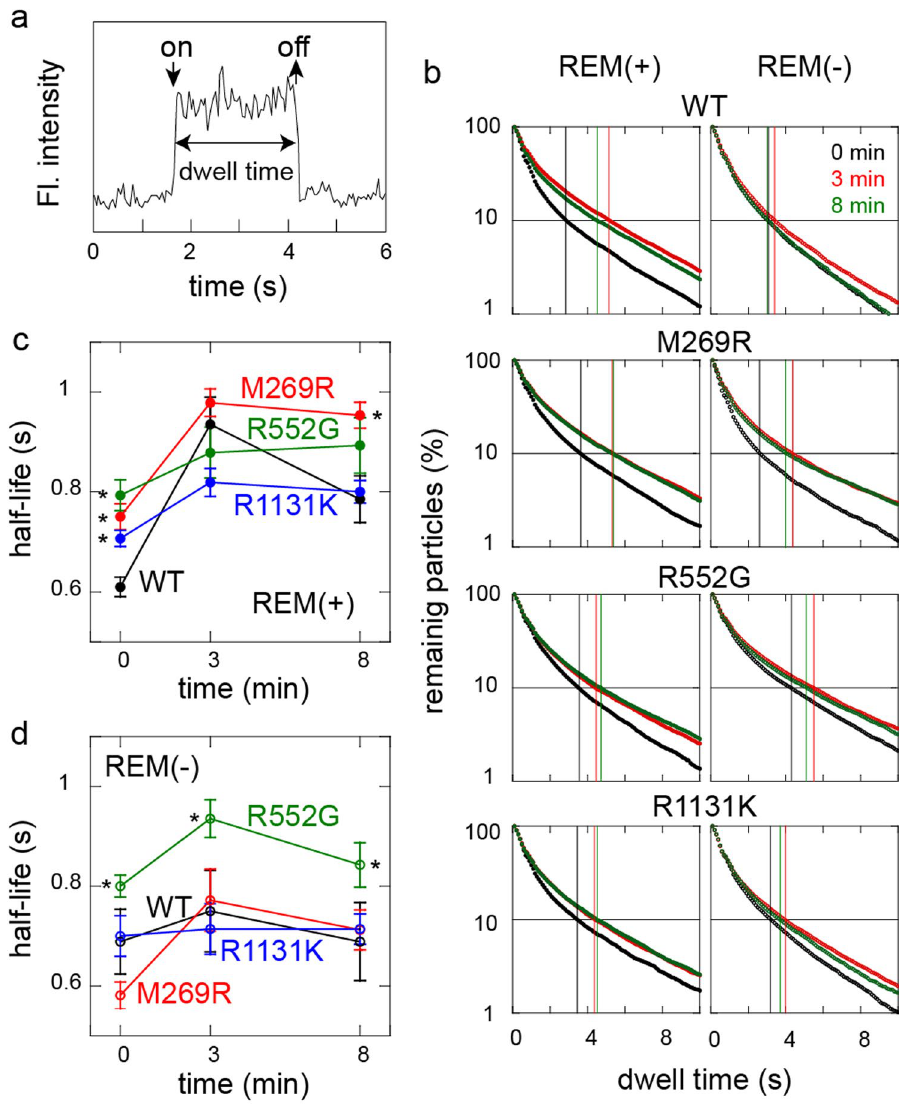
Figure 3. Dwell time distributions of NS SOS mutants on the cell surface. ( a ) Example of the change in fluorescence intensity on the cell surface, showing the association (on) and dissociation (off) of a single SOS molecule. ( b ) Release curves of SOS molecules from the cell surface. Molecules contained the REM( − ) mutation (left) or did not (right). A total of 624–7222 molecules were observed under each condition. Black, red, and green plots show the curves obtained after stimulation with EGF for 0, 3, and 8 min, respectively. The vertical lines show the dwell times at the 10% remaining points. ( c , d ) Half-lives of the SOS molecules on the cell surface were plotted as indicators of the dissociation kinetics. SOS molecules contained the REM( − ) mutation ( d ) or did not ( c ). Average of 7–10 cells shown with SE. Asterisks indicate a significant increase (p < 0.05 on Mann–Whitney test) compared with the WT or WT/REM( − ) under the corresponding